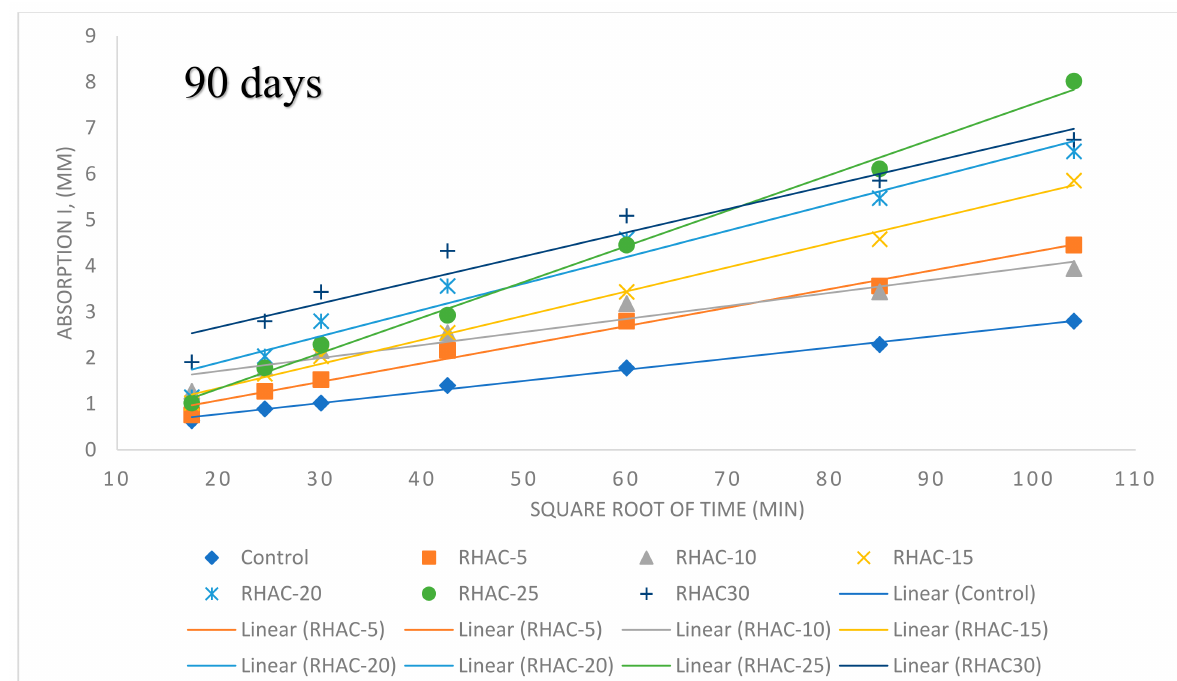
Figure 13. Sorptivity characteristics of HPCs with RHA for 90